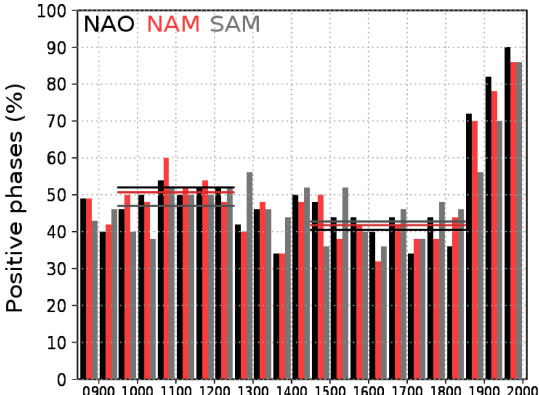
Figure 5. Percentage of years with positive NAO, NAM, and SAM indices for each interval of 50 years. Horizontal lines show the to- tal percentage for the MCA and the LIA. The differences between MCA and LIA are significant with p < 0 . 05 for NAO and NAM and with p < 0 . 15 for